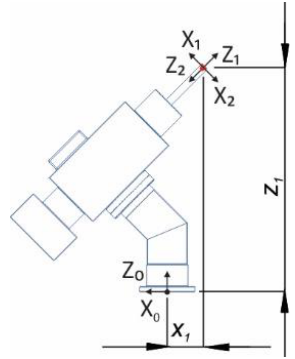
when collisions are considered. The deburring head also influences the structural properties of the robot and, thus, the machining accuracy [41]. Considering both aspects, a deburring head design, as shown in Figure 3, was chosen.